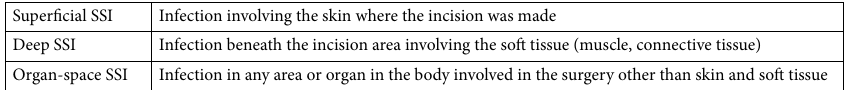
Table 1. CDC definitions of different types of surgical site infections. SSI surgical site